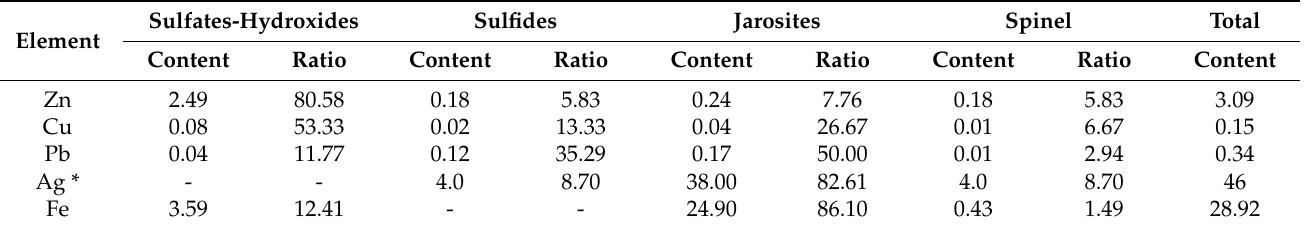
Table 3. Distribution of main relevant elements in various components of jarosite residue (mass%).